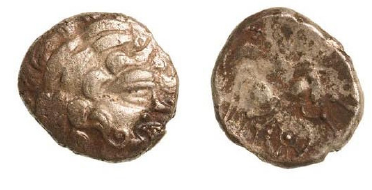
Figure 2. Example of a RGB image of both side of a coin. Figure 2, we can see rust in the coins and other color